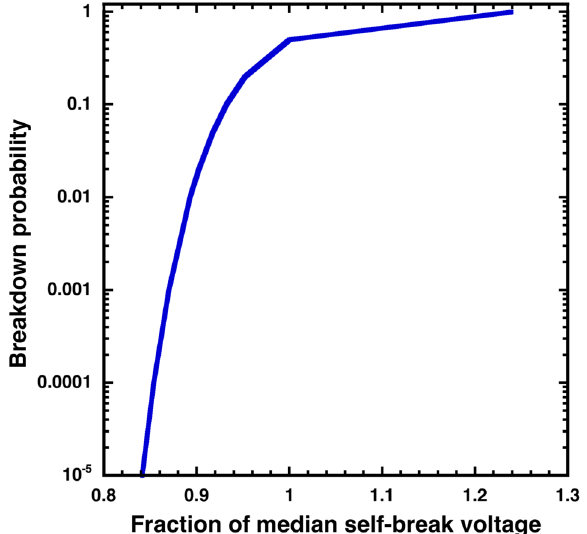
FIG. 6. (Color) Voltage output from pulser with pure SF 6 (circles) and a mixture of 90% N 2 and 10% SF 6 (squares). The tests were done at the same fraction of self-break voltage, and at 100 kV DC charge.